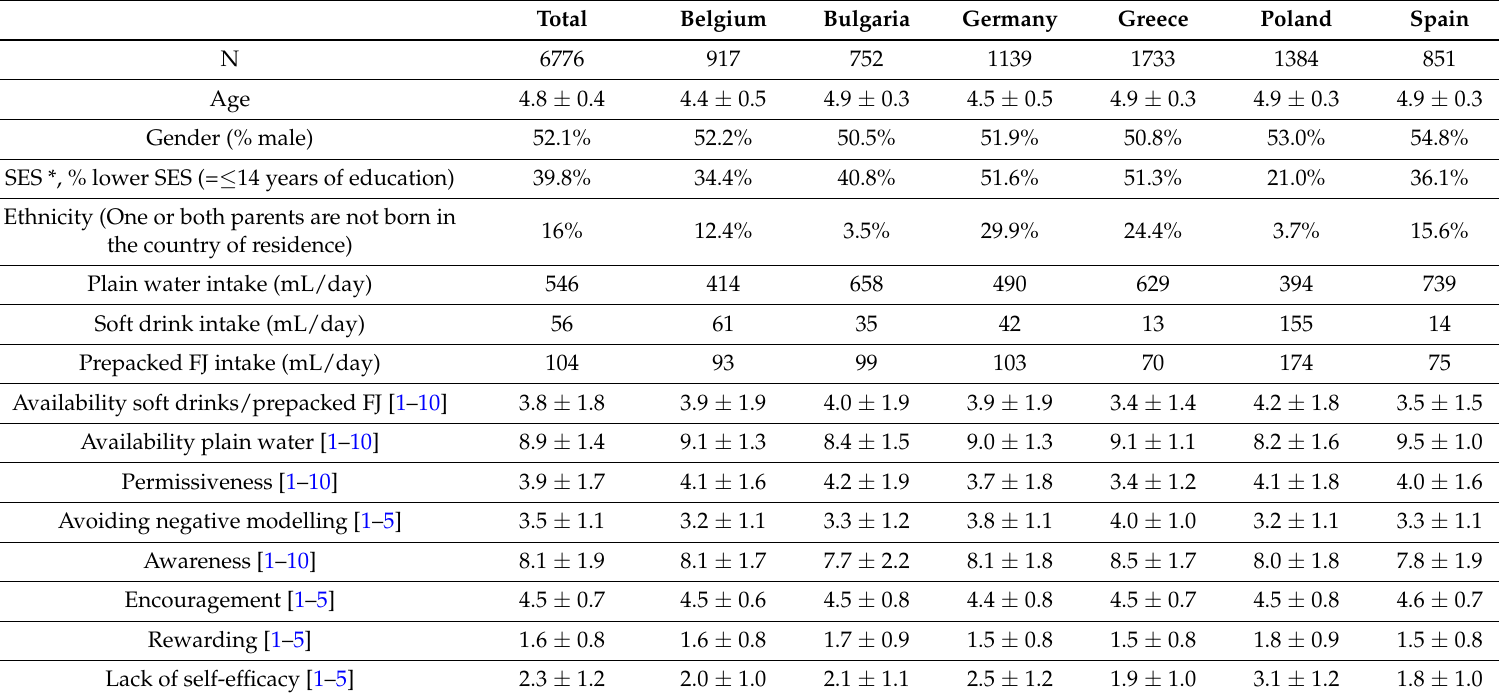
Table 2. Characteristics of participants of the total sample and each country